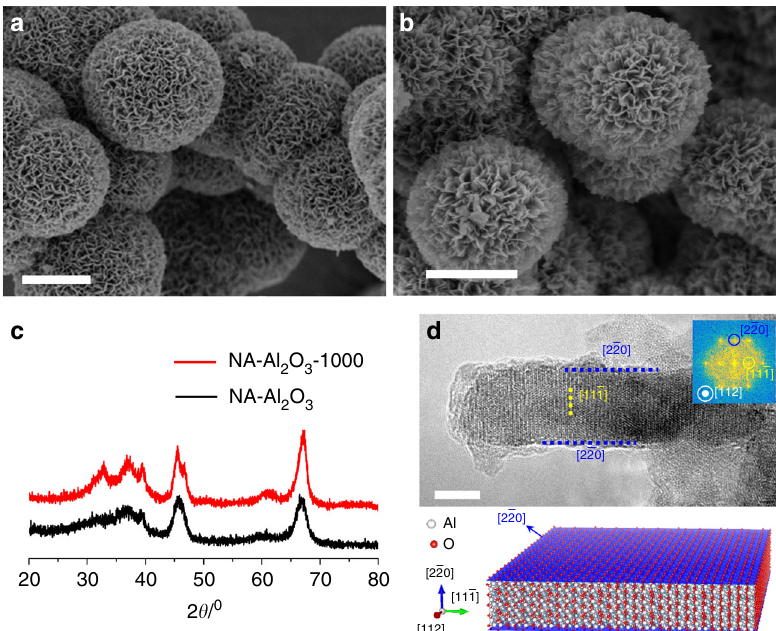
Fig. 2 Thermal characterization of NA-Al 2 O 3 host materials. a SEM images of NA-Al 2 O 3 . b SEM images of NA-Al 2 O 3 -1000. c XRD patterns of NA-Al 2 O 3 and NA-Al 2 O 3 -1000. d HRTEM image of a typical nanosheet of NA-Al 2 O 3 -1000. Upper panel: It was aligned to an edge-on condition, namely, a condition that the basal surfaces (220) of nanosheets were in parallel with the electron beam. The inset is the FFT pattern recorded from the nanosheet. Lower panel: A schematic diagram showing the geometry of the nanosheets. The two basal planes of the nanosheet are colored blue. The scale bar in ( a and b corresponds to 2 µ m, and in d corresponds to 5